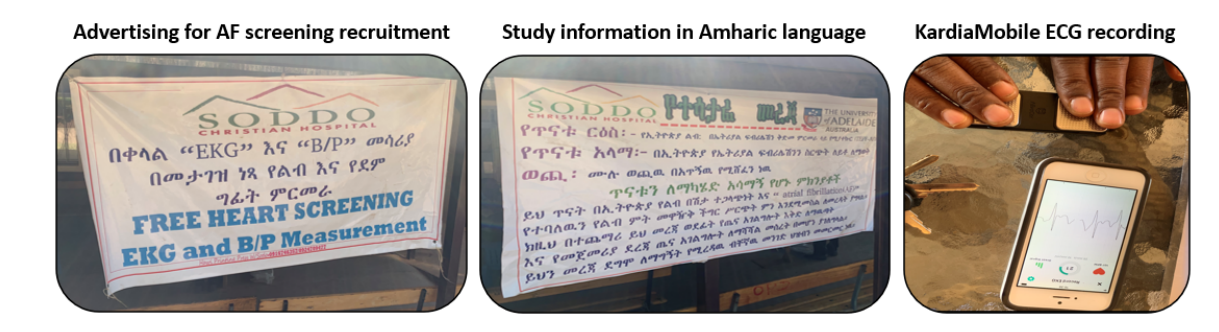
Figure 1. Atrial fibrillation screening advertising (left) and study information (center, in Amharic language) and single-lead electrocardiogram recording